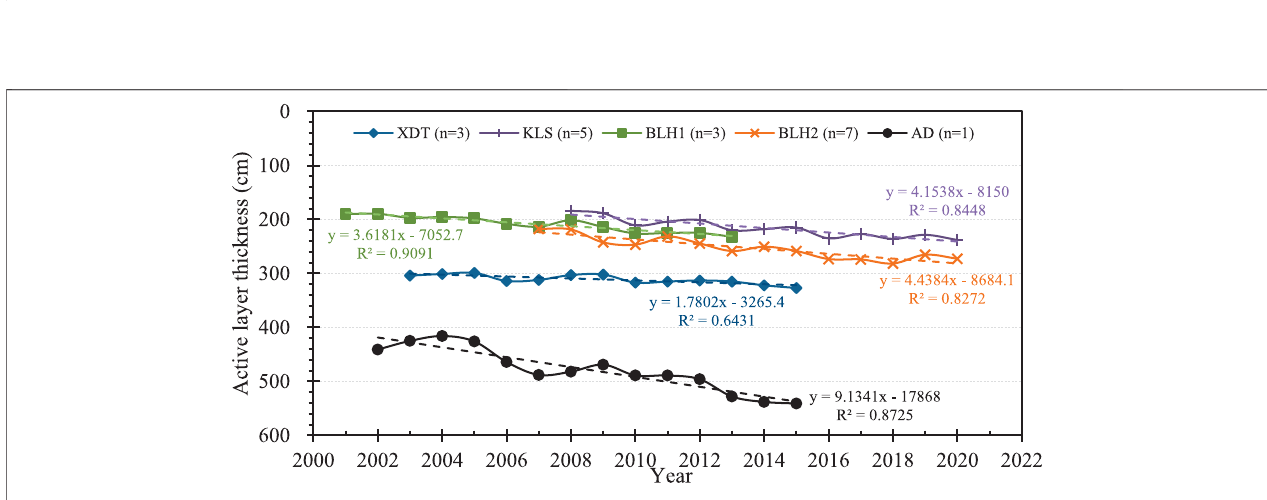
FIGURE 6 | Recent variations in active layer thickness (ALT) at four sites for nearly 20 years. The data are an average value of several boreholes (n) at each site.